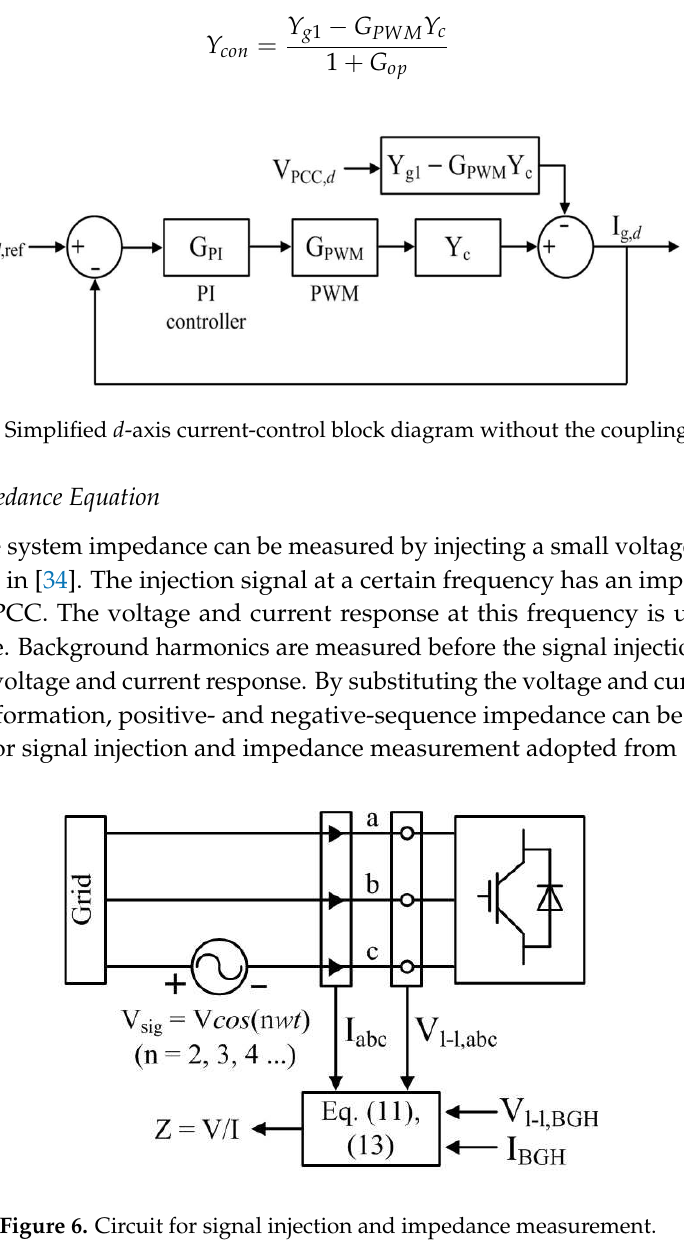
Figure 6. Circuit for signal injection and impedance